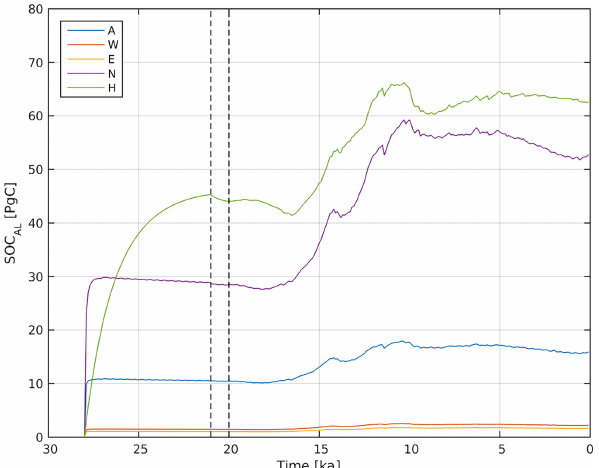
Figure A13. Simulation set-up for deglacial model runs. Shown is the spin-up and fully transient phase of active layer SOC pools for all SOM lability classes (A, W, E, N, H) from the experiment ini- tialization at 28 to 0ka. The vertical dashed line at 21ka illustrates the end of the SOC spin-up phase, the vertical dashed line at 20ka illustrates the end of the stationary LGM climate forcing. Individual SOC contributions were summed over all permafrost grid